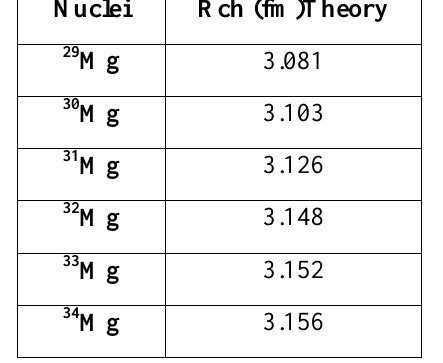
Fig. 1: The relation between the rms for charge and the number of nucleon of 29-34 Mg nuclei. Table 1: The values of the root mean square for charge of 29-34 Mg nuclei.